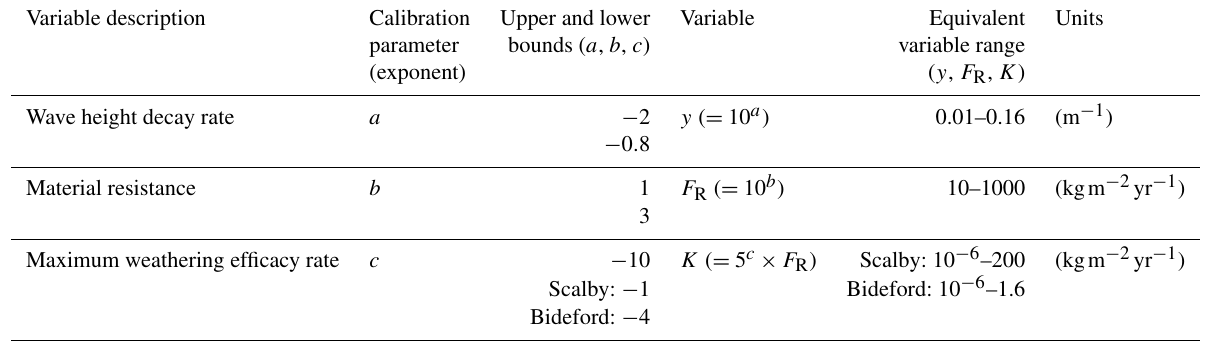
Table 2. Free variables, corresponding calibration parameters and their units, and lower and upper bounds used in the MCMC calculations.